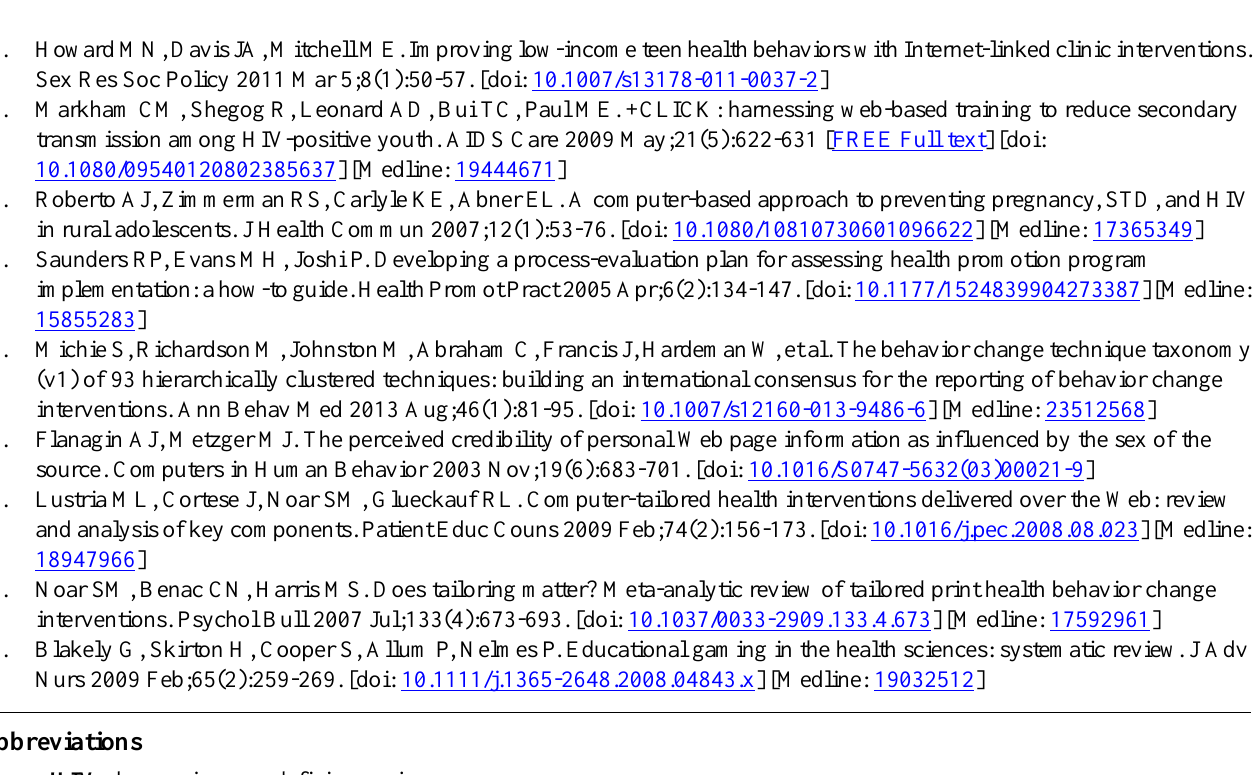
Abbreviations HIV: human immunodeficiency virus IMB: Information-Motivation-Behavioral skills STI: sexually transmitted